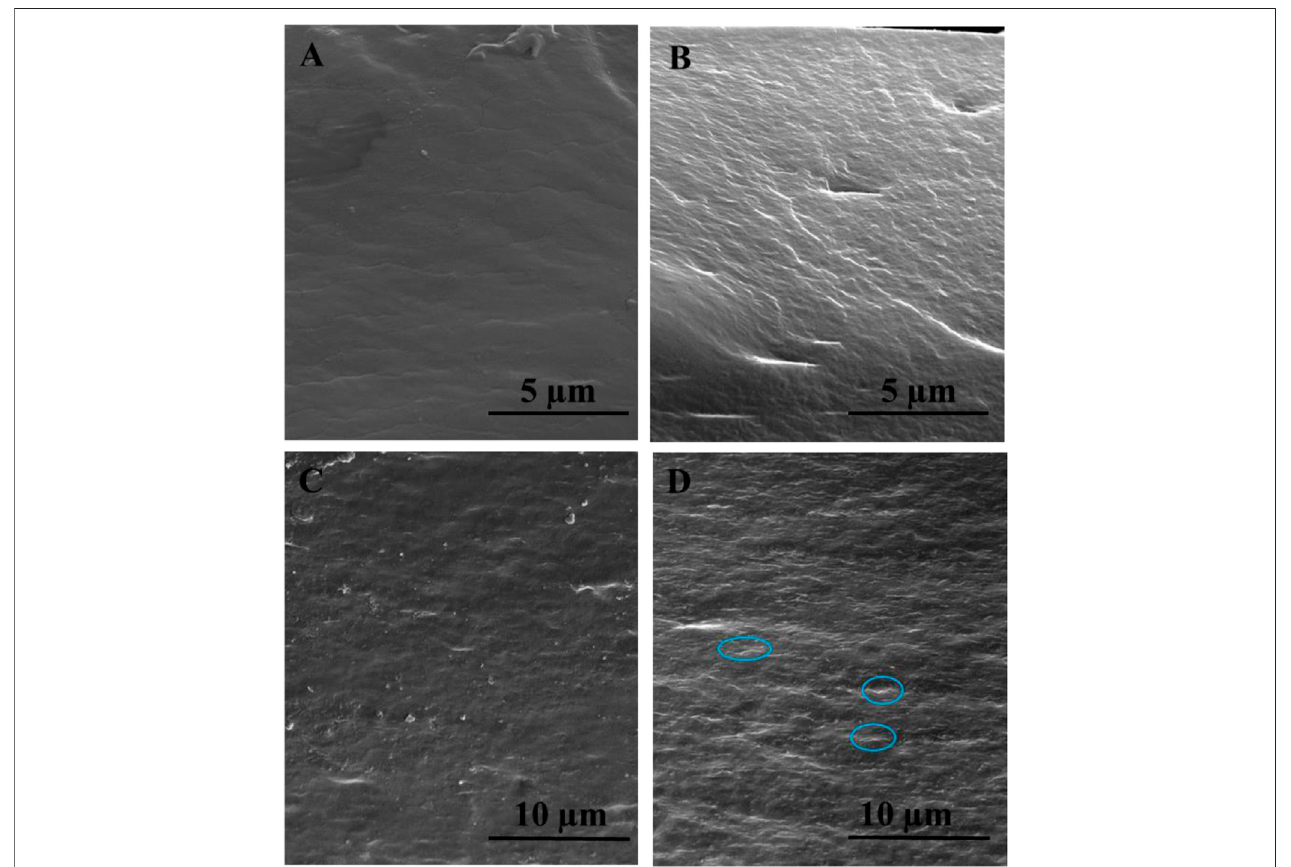
FIGURE5| Cross-sectionalscanningelectronmicroscopicimagesofthetypicallyselectedsamples: (A) pristineCS, (B) CS/B, (C) CS/B/025G/025C,and (D) CS/ B/1G/1C. GO sheets are highlighted with circles.